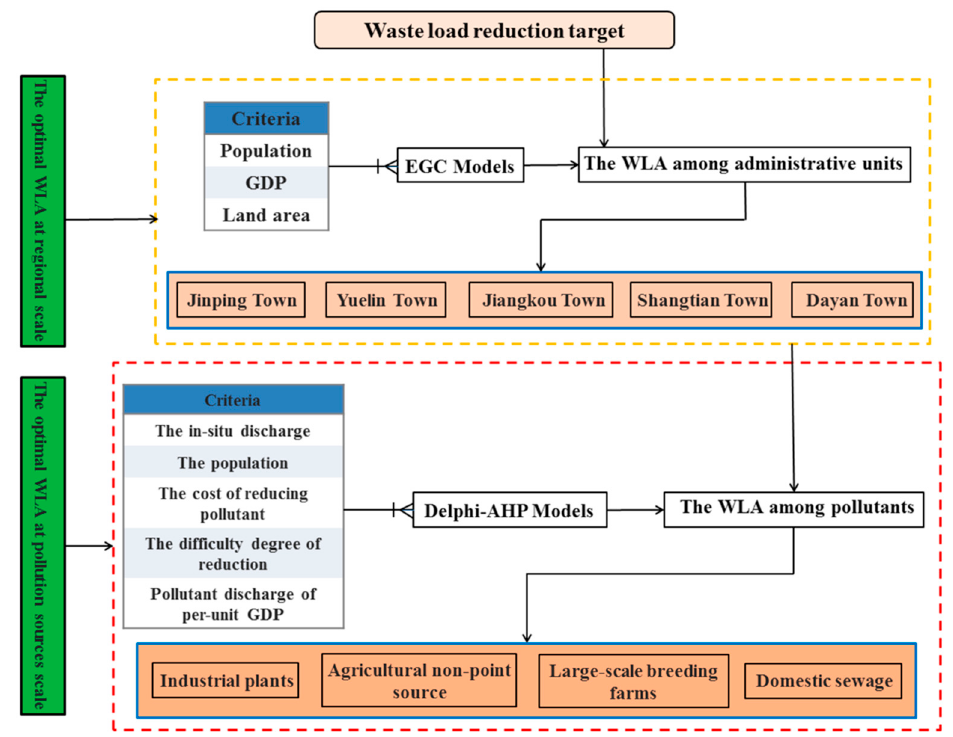
Figure 2. An integrated, multi-scale, and multi-sector optimal waste load allocation (WLA) framework in the Xian-jiang watershed, China.